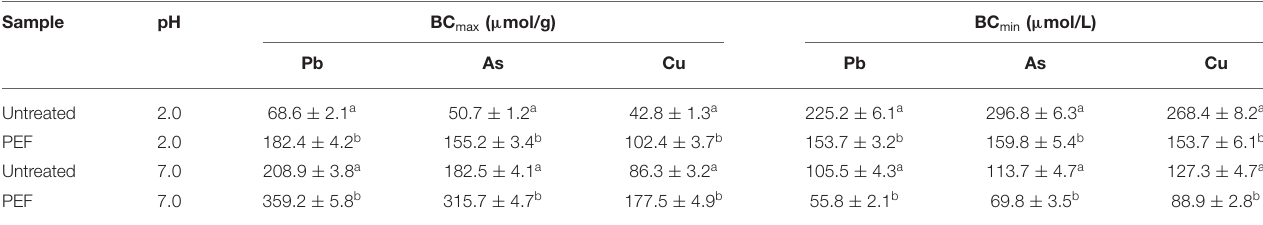
The values represent means of triplicates ± standard deviation. Values in the same column with different letters are significantly different (p < 0.05). A PEF treatment parameters: 6.0 kV/cm, the number of pulses 30, the liquid-solid ratio of 15:1, extraction time of 20min, and temperature of 45 ◦ C.